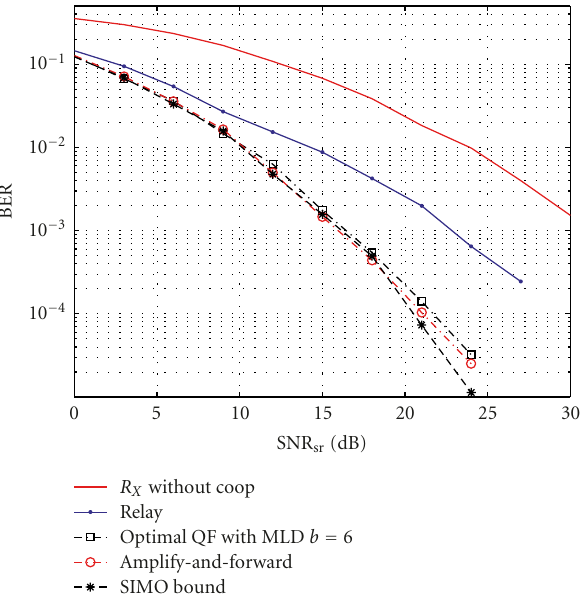
Figure 4: Comparison between the optimum QF ( b = 6) and the AF schemes in quasistatic channels for SNR rd = 40dB, SNR sr = SNR sd + 10dB.